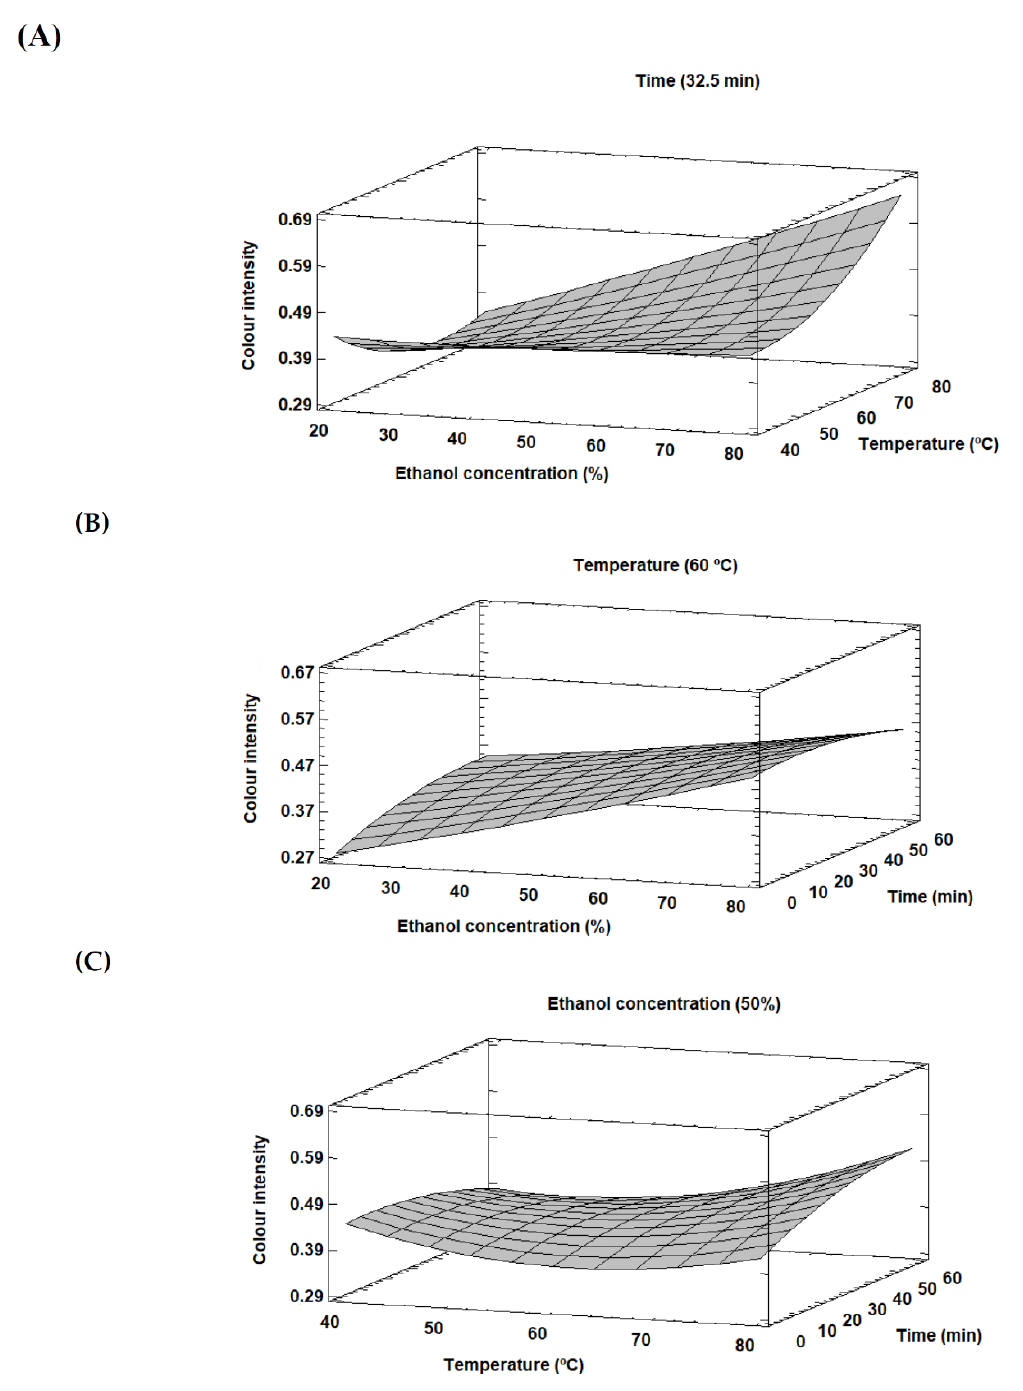
Figure 2. Response surface plots showing the effect of the studied variables on the colour intensity for LP. Interactions between ethanol concentration-temperature ( A ), ethanol concentration-time ( B ) and temperature-time ( C ).